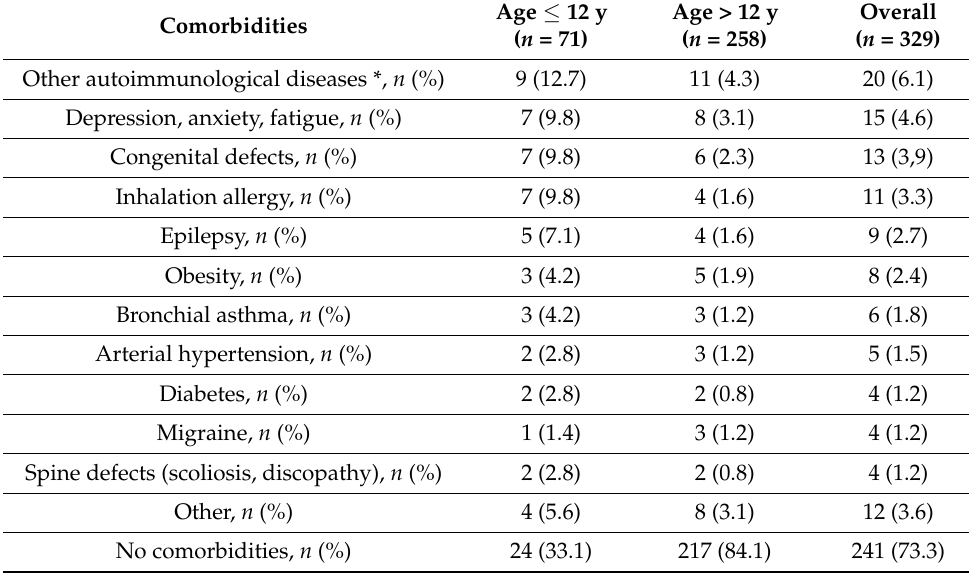
Table 3. Comorbidities of the patients with POMS.